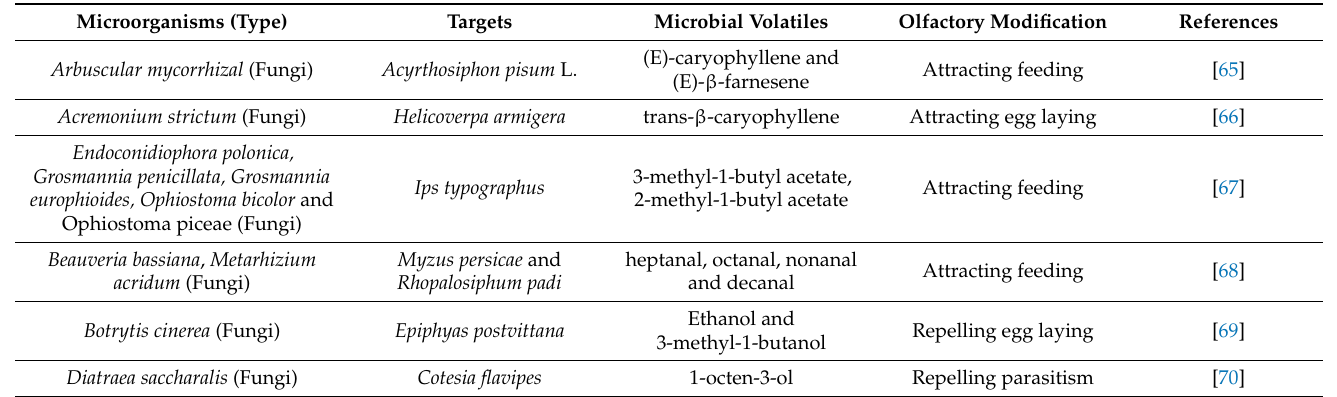
Table 2. Cases of microorganism-induced host volatiles trigger changes in insect behaviors through olfactory